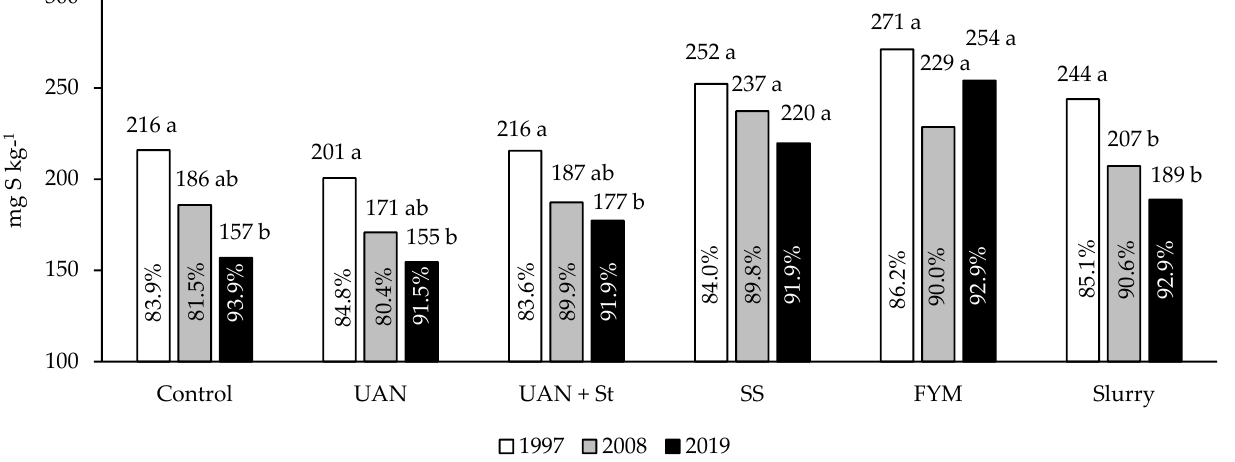
Figure 7. Content of pseudo-total sulfur fraction (S pt ) in topsoil. Different letters describe statistically significant differences between years within the treatment. Tukey HSD test ( p < 0.05), ( n = 4). Percentages shown inside the columns are a proportion of organic sulfur fraction out of pseudo-total sulfur content.